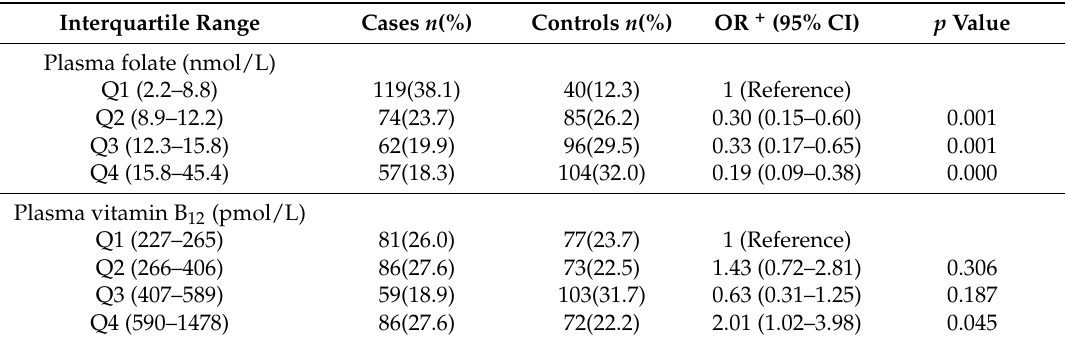
Table 2. Odds ratios (OR) and 95% confidence intervals (CI) of hepatocellular carcinoma (HCC) by quartile of plasma folate and vitamin B 12